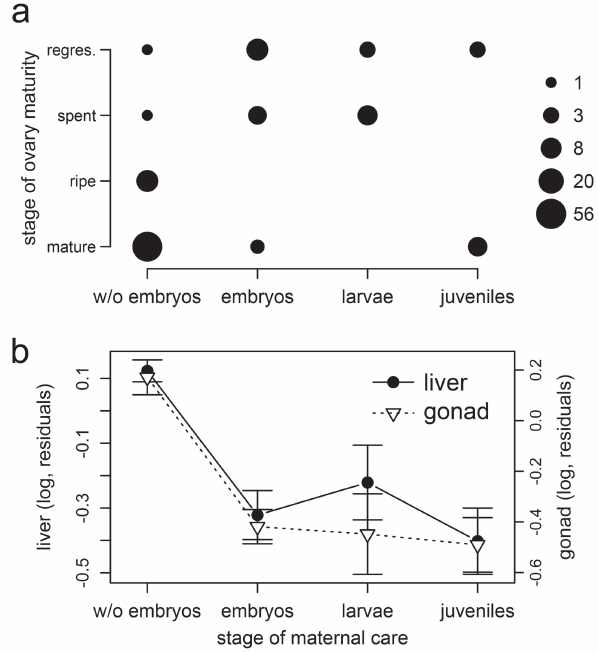
Fig. 4. Differences between females that were not performing parental care and mouth-brooding females: (a) stage of ovary maturity, with circle size indicating number of females in each condition; (b) liver and ovary